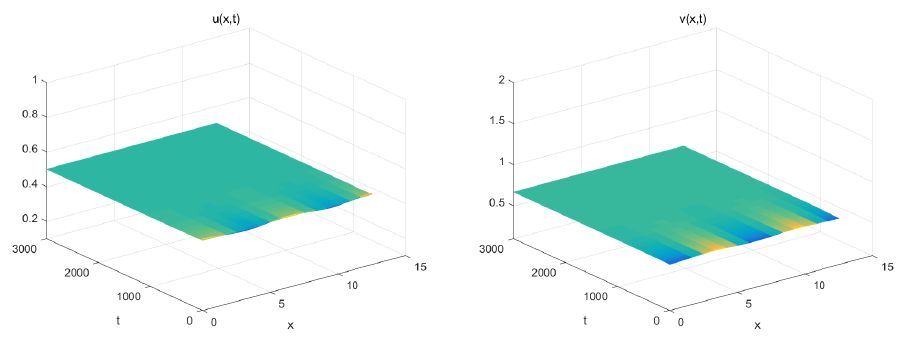
0.1, 0.01 ) D 1 . Where A 0 is the coexistence equilibrium, which is − − ∈